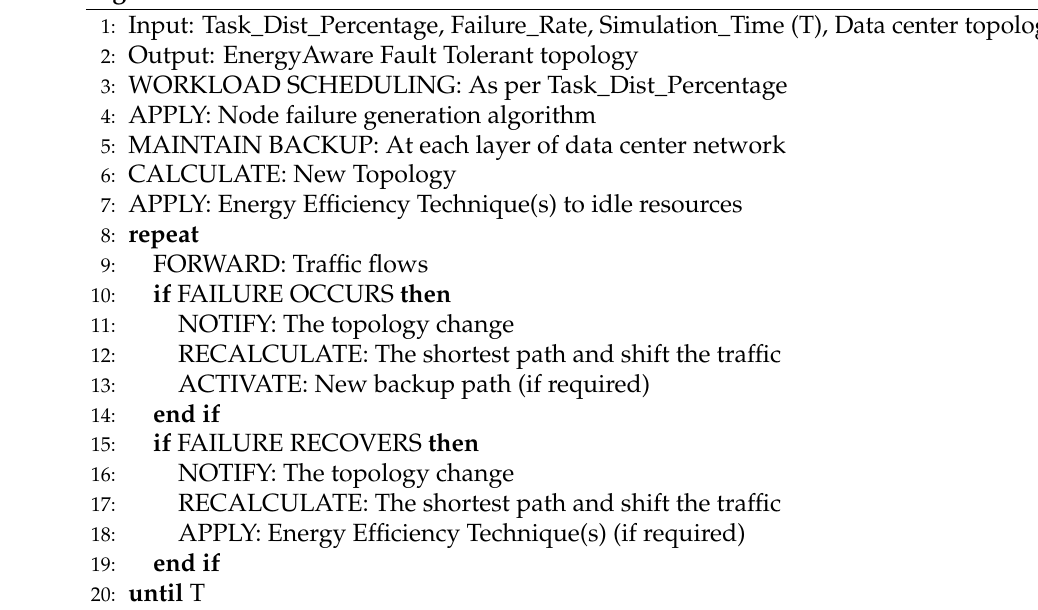
Algorithm 1 Pseudo code for